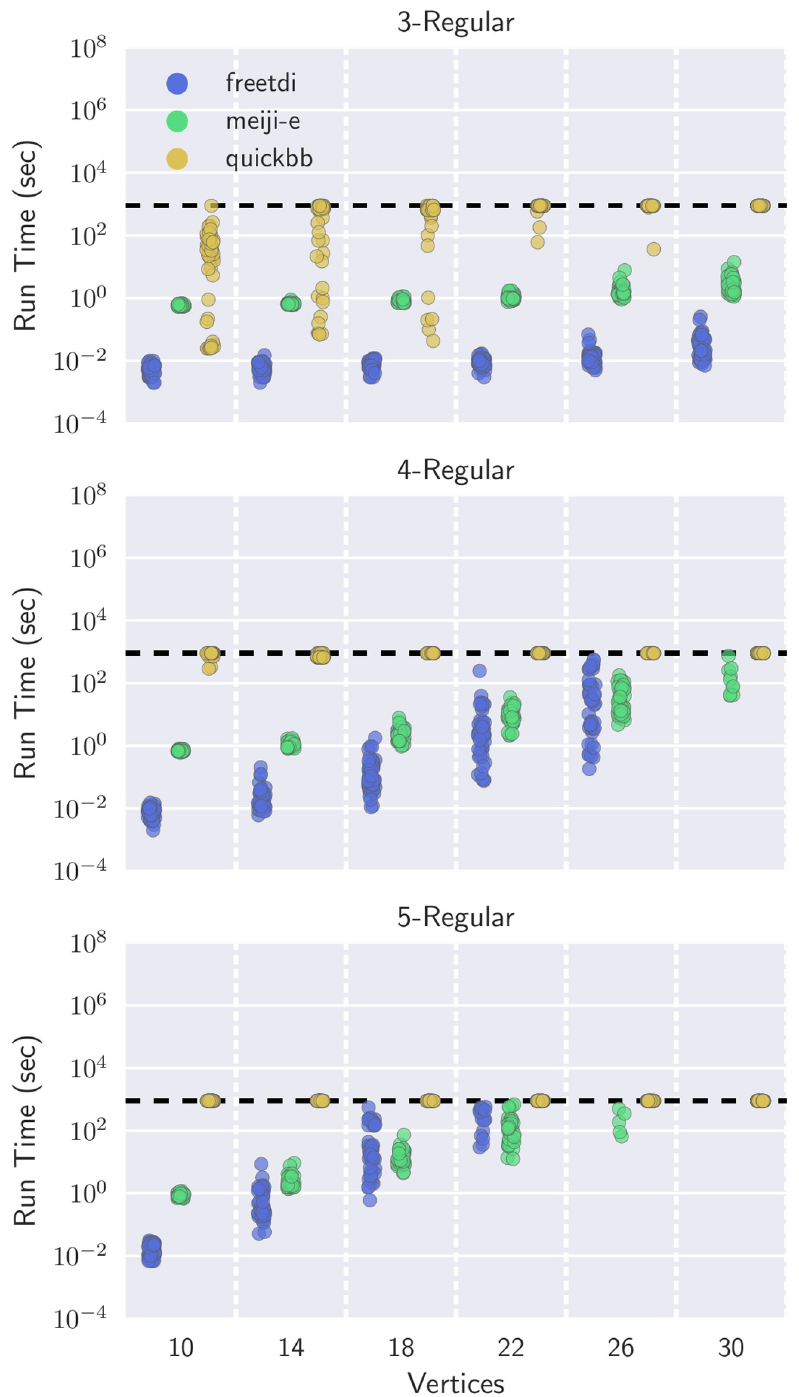
Fig 6. Run times for freetdi , meiji-e , and quickbb on QAOA circuits for computing M AX C UT on r -regular graphs. 25 random regular graphs are generated at each r , | V | level using NetworkX, and algorithms were timed out at 15 minutes (horizontal